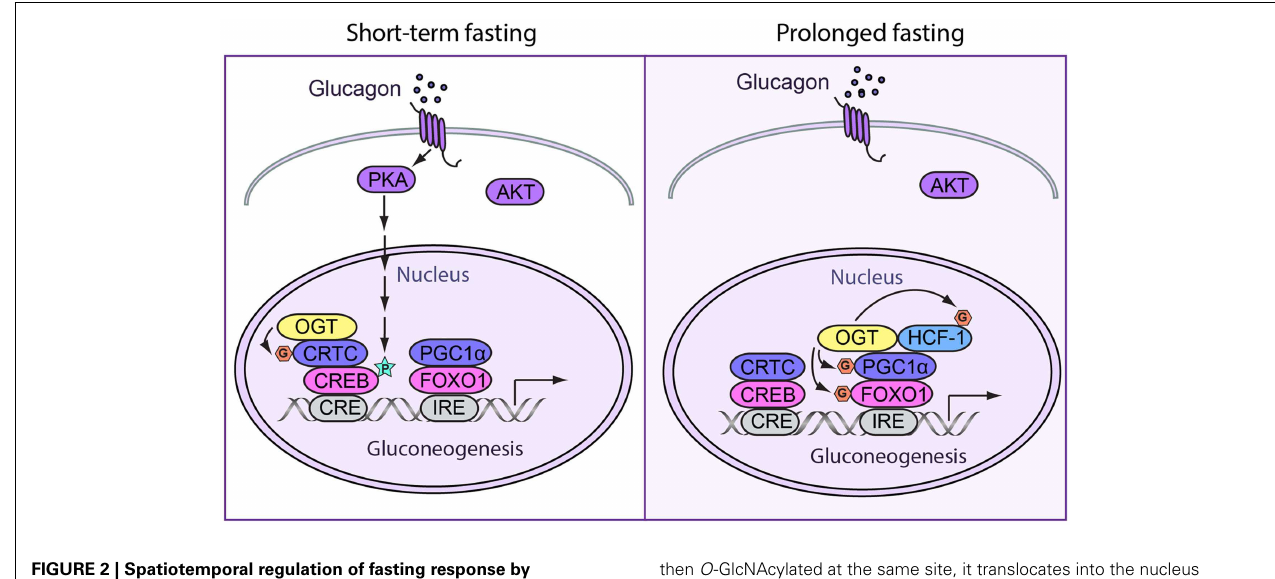
FIGURE 2 | Spatiotemporal regulation of fasting response by O -GlcNAcylation . (Left) During short-term fasting, glucagon stimulates gluconeogenesis by enhancing the activity of CREB. Phosphorylation of CREB by PKA directly promotes gluconeogenic gene expression. Additionally, OGT can induce gluconeogenesis by O -GlcNAcylating CRTC2, the co-activator of CREB.When CRTC2 is dephosphorylated and